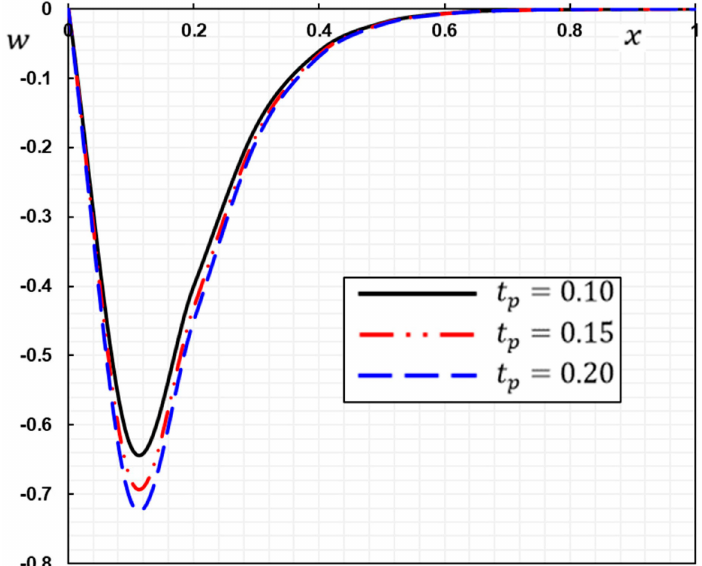
Figure 3. Variation of deflection w against laser pulse duration t p .